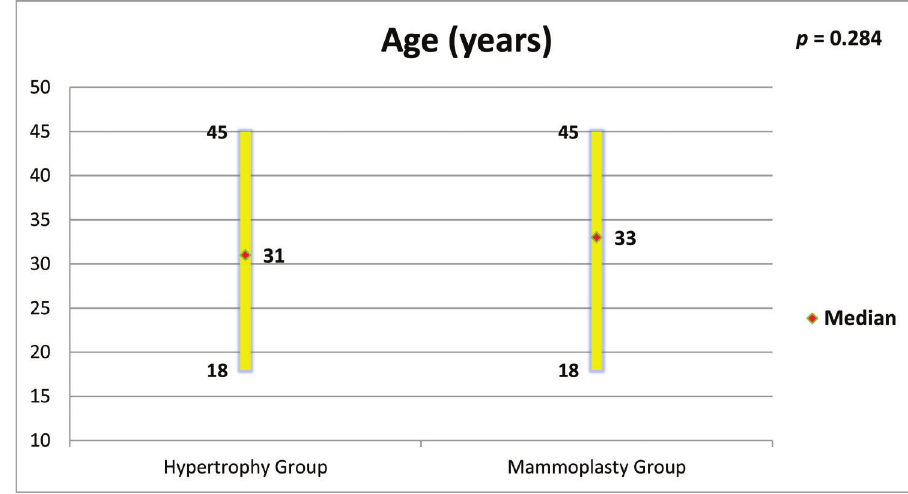
Figure 1 - Age of women in both groups and comparison by the Mann-Whitney